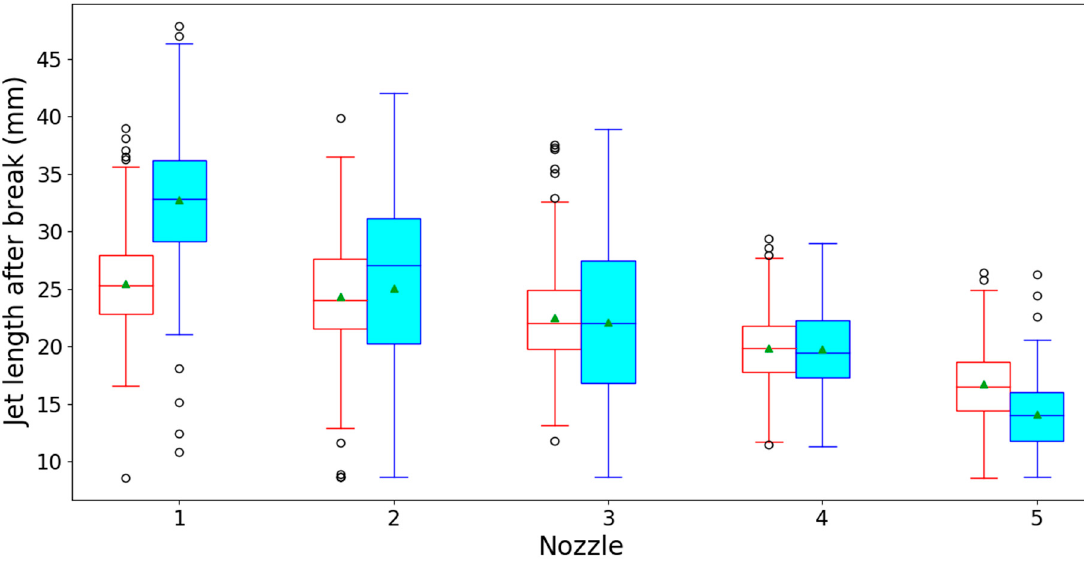
Figure 6. Jet lengths for the various showerheads and nozzles at 8 L min − 1 and 35.8 °C taken from frames right after a filament had broken off.